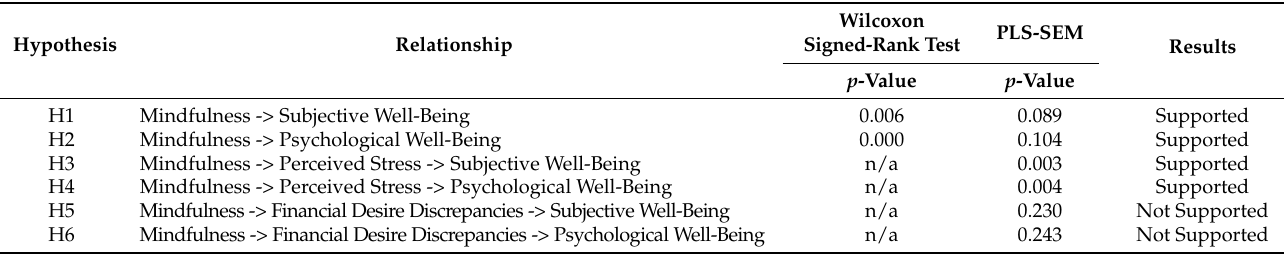
Table 9. Overall Findings (Hypotheses